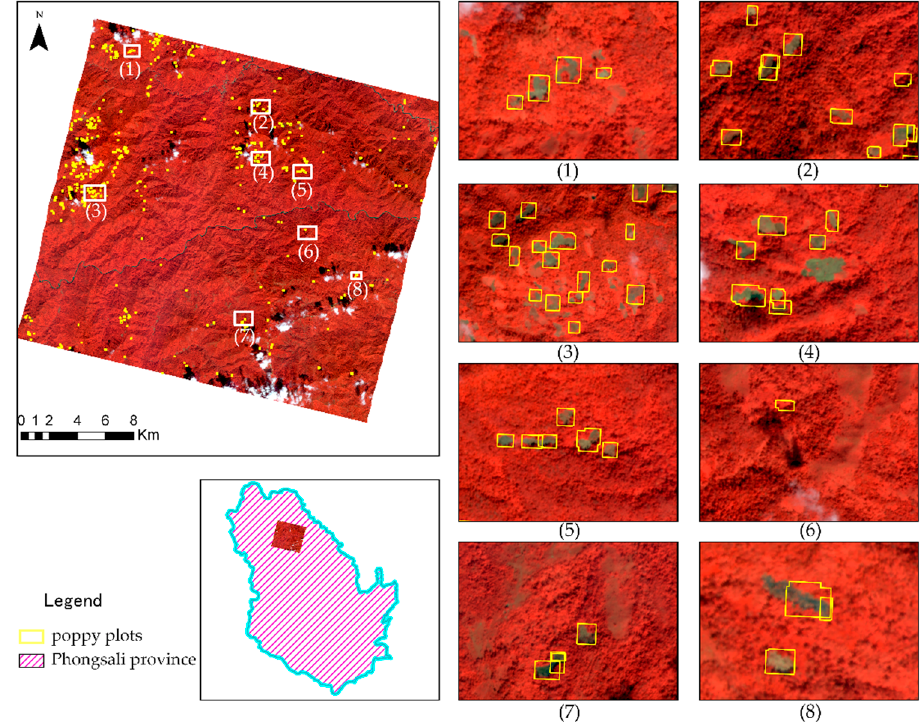
Figure 16. Spatial distribution maps of poppy parcels using the GF-2 image, yellow polygons are poppy parcels predicted by the model.